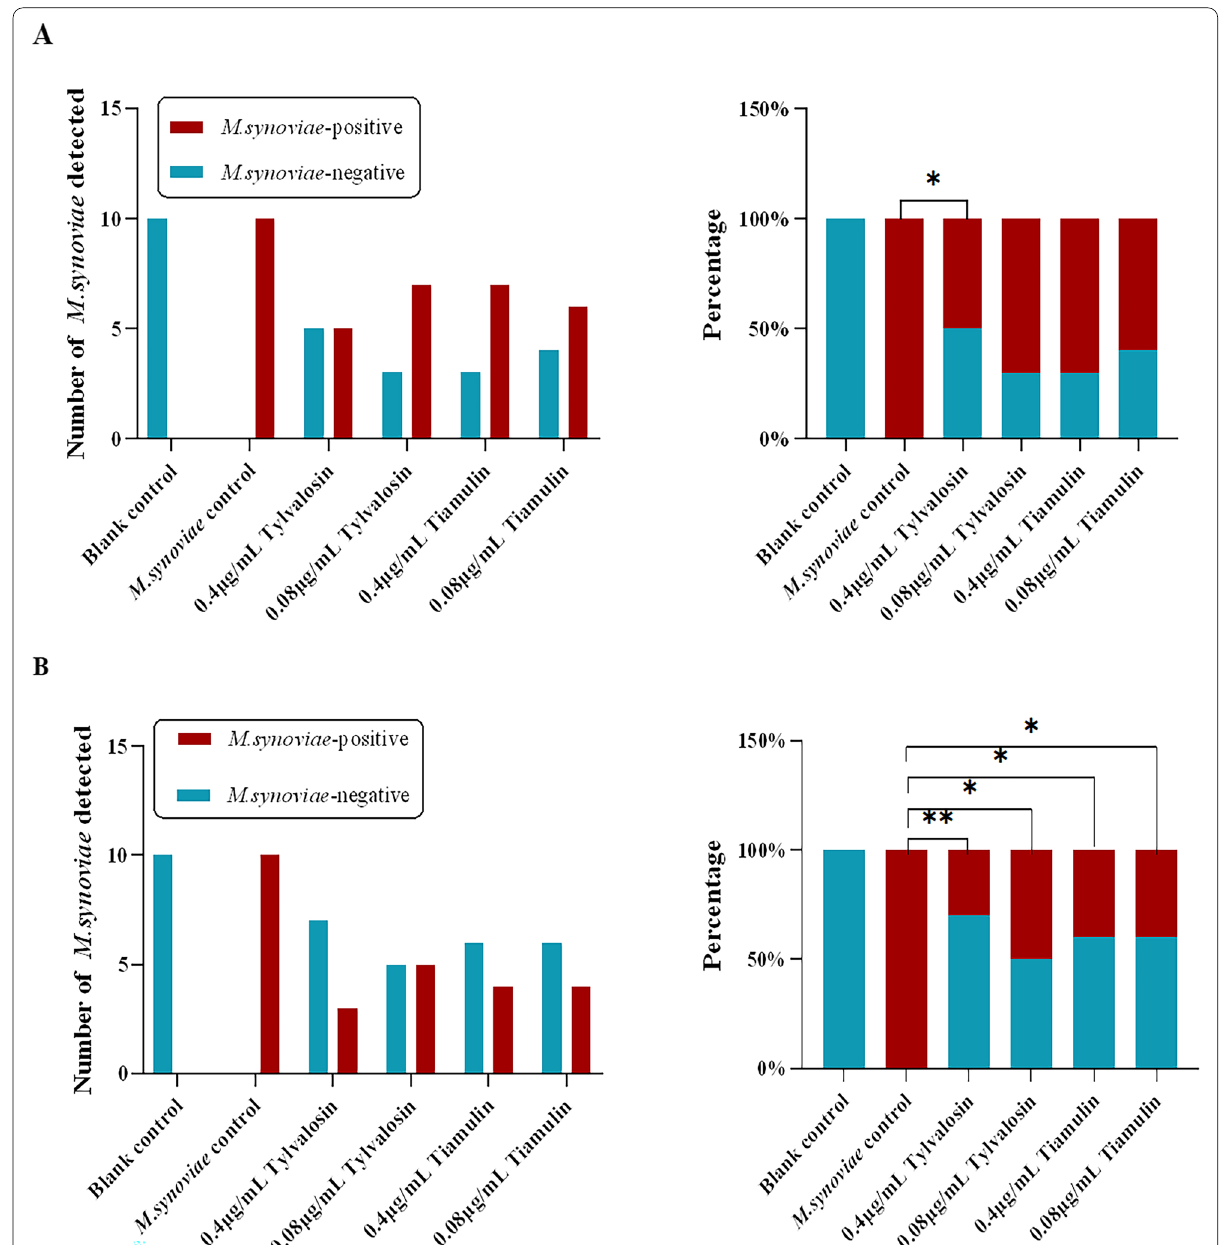
Fig. 4 Number and percentage of M. synoviae detected during treatment. A Third day of treatment; B Fifth day of treatment. Asterisks in the figures indicate significant differences (* P < 0.05; ** P <